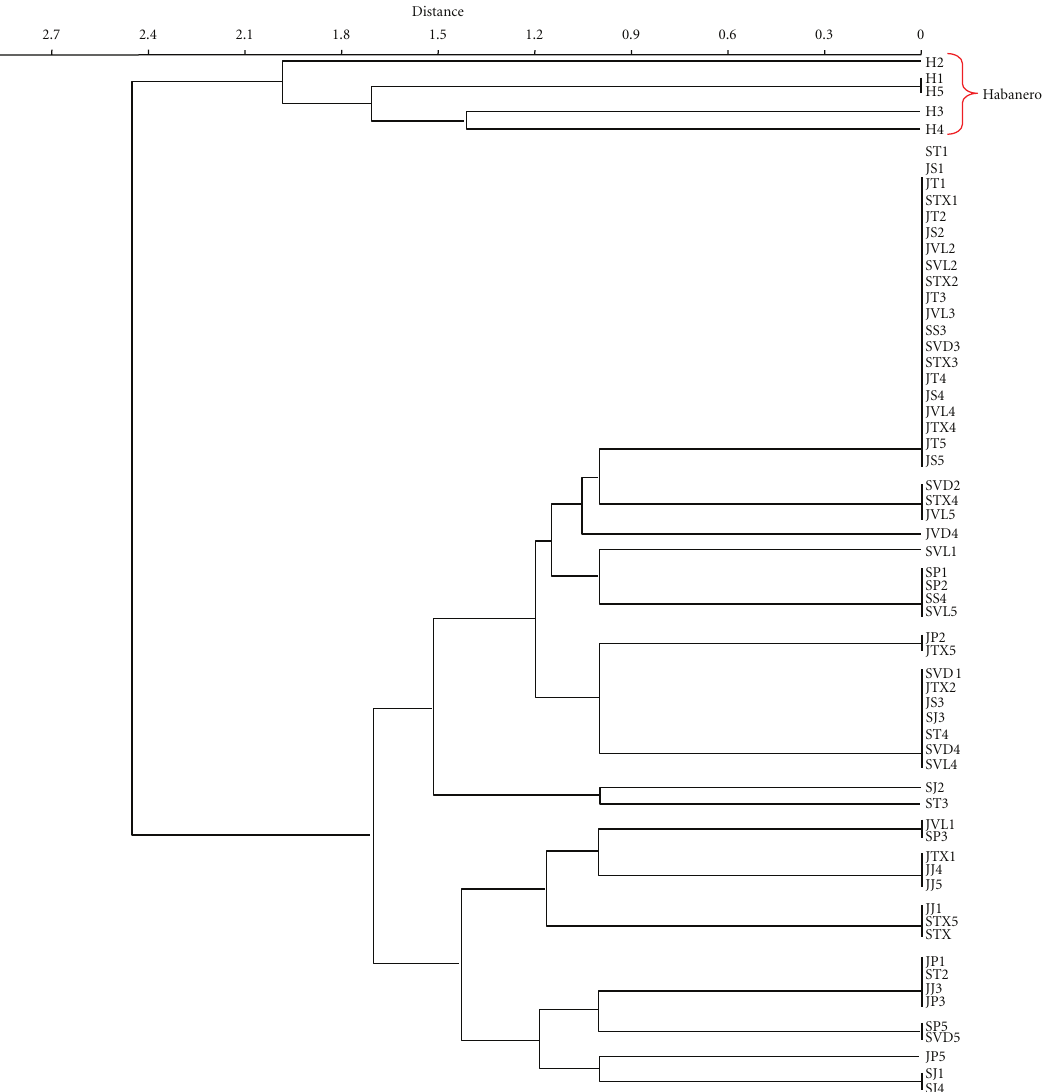
Figure 4: Euclidean distance dendrogram of C. annuum L . (Jalape˜no and Serrano chilli peppers) and C. chinense Jacq . (Habanero chilli peppers) based in OPE-18 RAPD